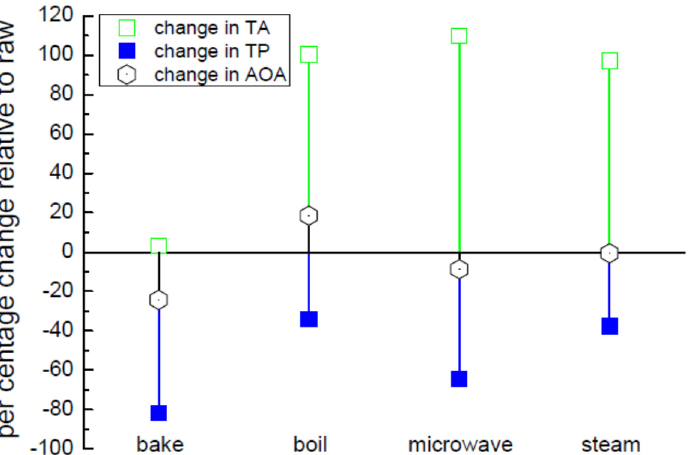
Figure 10. Change in bioactive content in purple potato, relative to uncooked, seen using different cooking methods. TP—total phenolic compounds, TA—total anthocyanins and AOA—antioxidant activity. Adapted from [46].